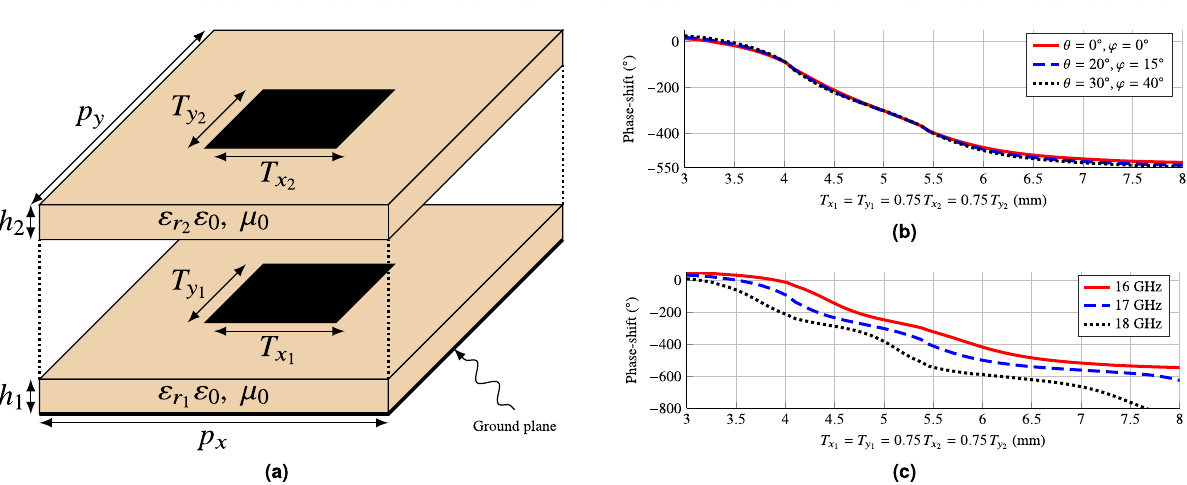
Figure 5. ( a ) Sketch of the employed unit cell. It consists in two stacked rectangular patches (here drawn separately) backed by a ground plane with periodicity p x = p y = 8.82mm . The commercial substrate Rogers 3003 has been employed for both layers with thickness of h 1 = 30mil for the bottom layer and h 2 = 60mil for the top layer. ( b ) Phase response of the unit cell as a function of the patch size for different angles of incidence at 17 GHz. As it can be seen, the phase-shift is stable for all considered angles. ( c ) Phase-shift introduced by the unit cell for different frequencies for oblique incidence with ( θ , ϕ) = ( 40 ◦ , 30 ◦